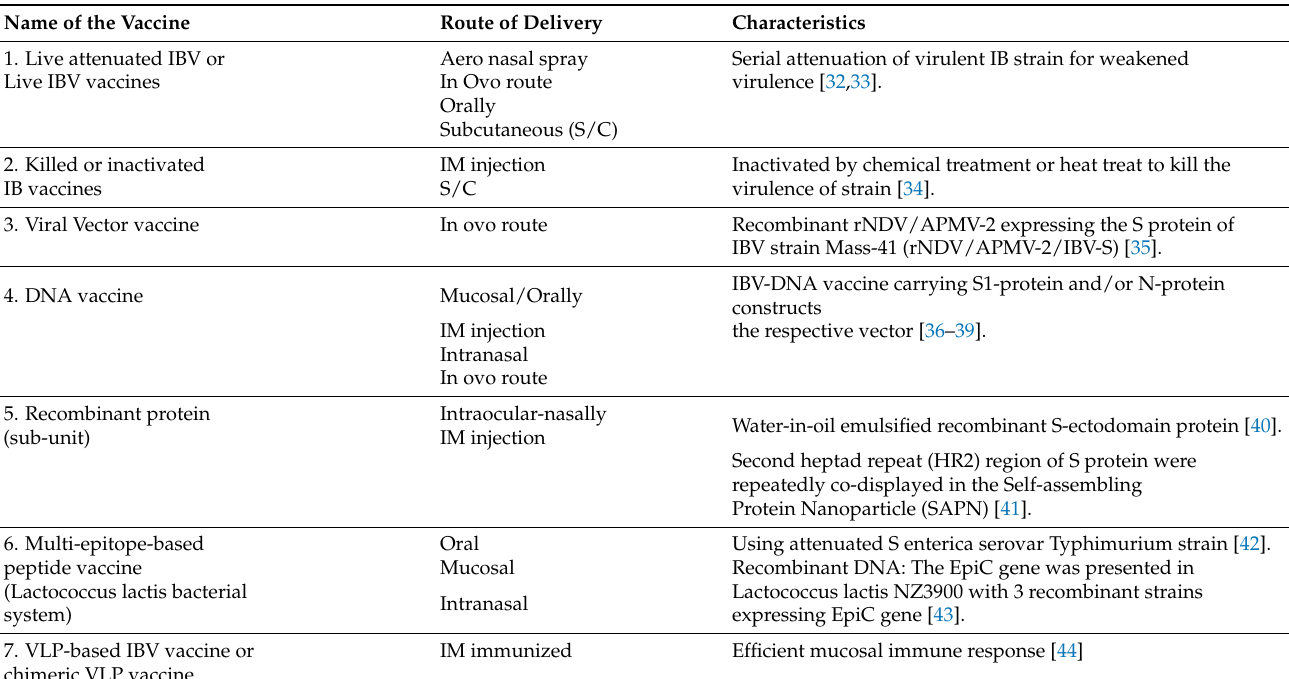
Table 1. Routes of delivery of various IBV vaccines with their associated